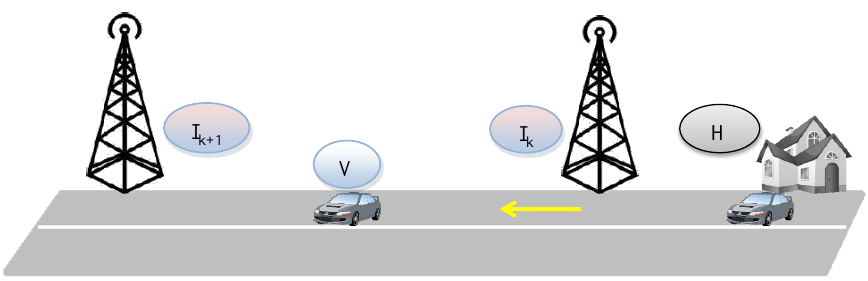
Figure 2. Scenario of the basic Social Internet of Vehicles (SIoV) model.